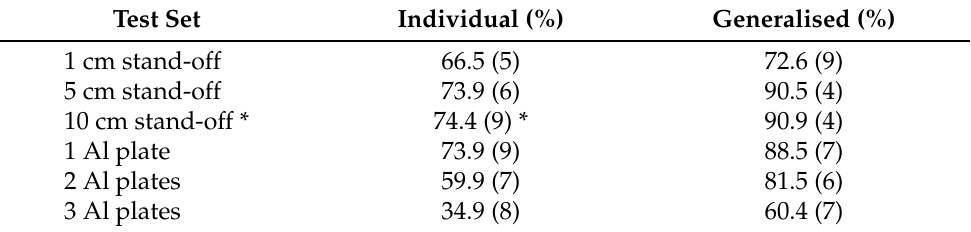
Table 5. Average perfect classification rates for all scenarios. The generalised model is compared with those trained individually on each set. Reference model developed on marked data set